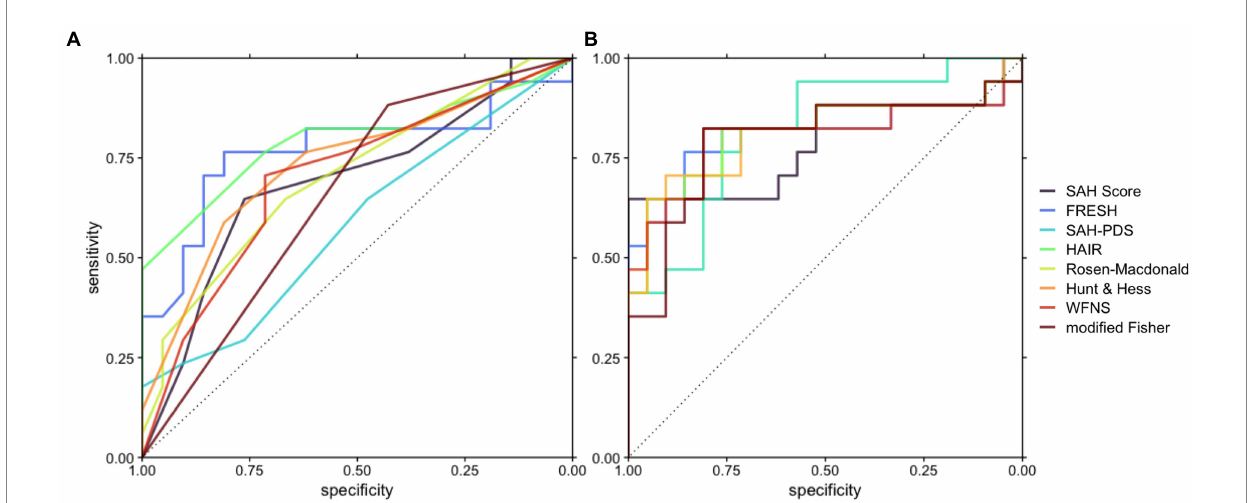
FIGURE 1 Receiver operating characteristic curves depicting the accuracy of prognostic models based on the respective scores with or without Arg/Orn. (A) Prognostic models including the respective score. (B) Prognostic models including Arg/Orn and the respective